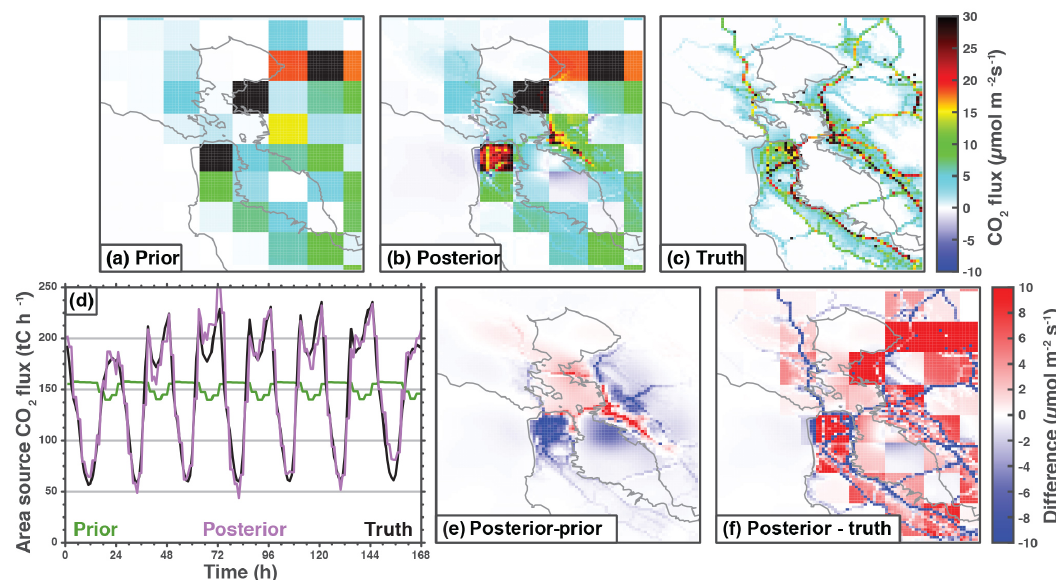
Figure 3. Example of estimated CO 2 fluxes. Top row shows the average emissions from (a) the prior, (b) the posterior, and (c) the true emissions. Panel (d) shows a time series of the emissions from the area source with the prior (green), posterior (pink), and true emissions (black). Panel (e) shows the difference between the posterior and the prior. Panel (f) shows the difference between posterior and the truth. Posterior output is from the best-case scenario ( n s = 34 and σ m = 0 .